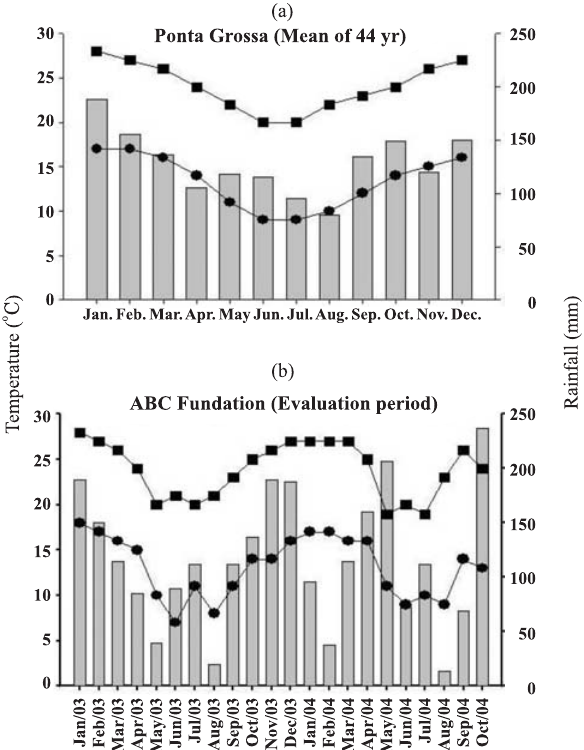
Figure 1. Monthly rainfall distribution (bars) with maximum ( Tmax) and minimum ( Tmin) temperatures. Historical data for Ponta Grossa (a) and for the period from January 2003 to October 2004 (b).